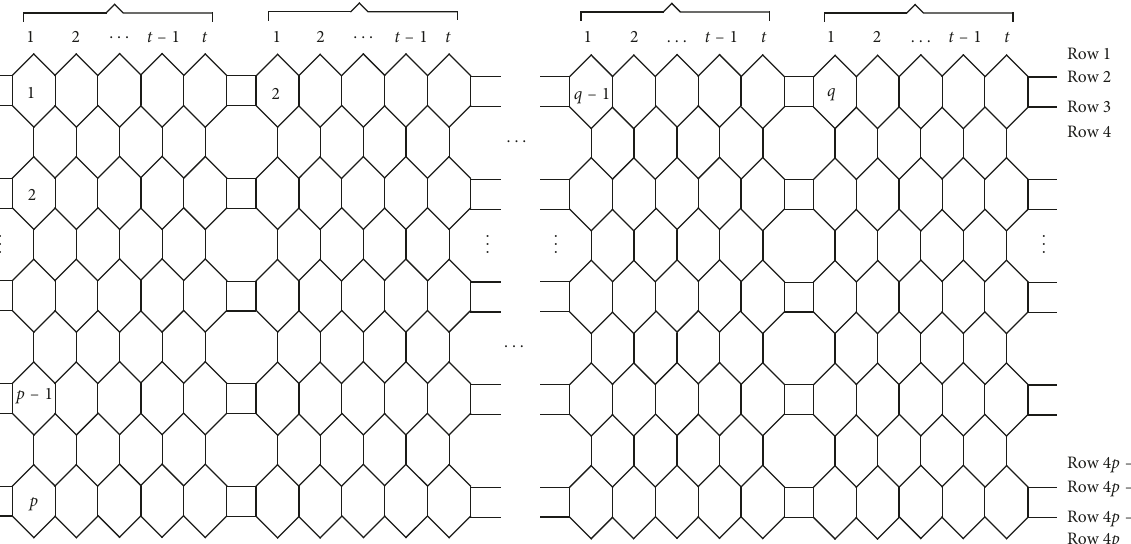
Figure 2: The generalized molecular graph of the t -polyacenic nanotube P t